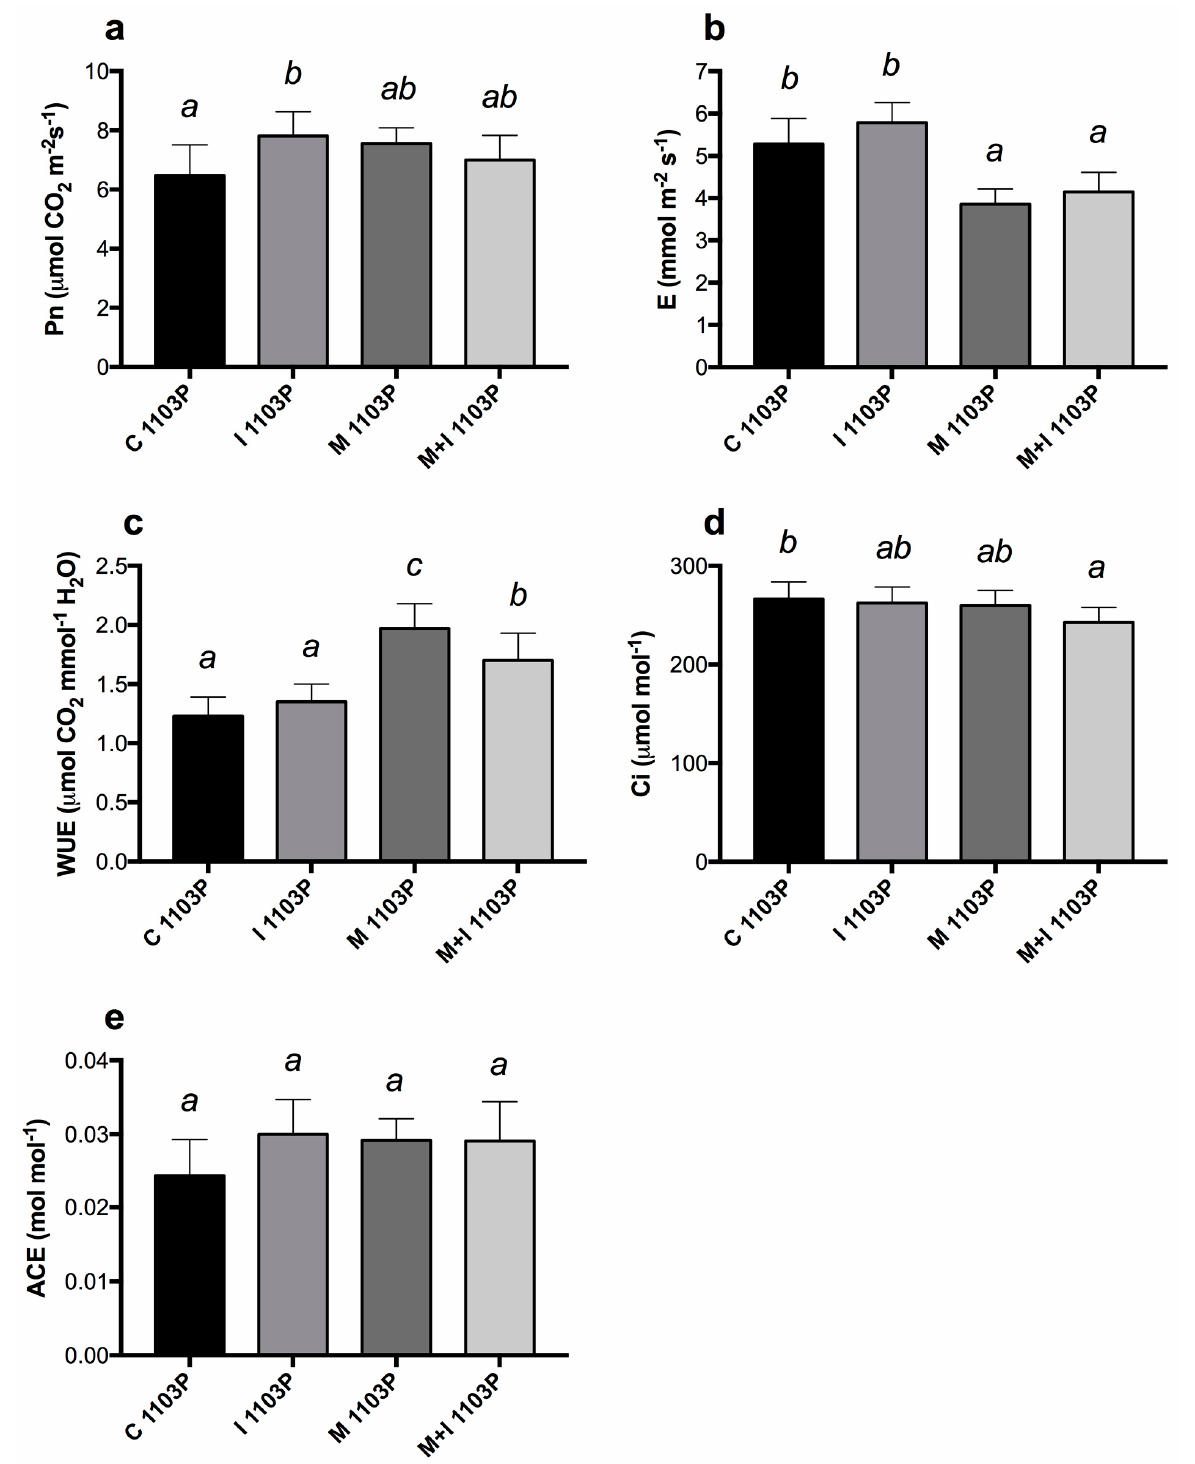
Figure 3. Leaf gas exchange in ‘Glera’ plants grafted onto 1103P rootstock at véraison. Performances of net photosynthesis (Pn) ( a ), transpirations ( b ), water use efficiency (WUE) ( c ), intercellular CO 2 concentration (Ci) ( d ), apparent carboxylation efficiency (ACE) ( e ). Data are expressed as mean ± SD ( n = 10) of randomly selected plants over 2020 and 2021 seasons. Different lowercase letters above the bars indicate significant differences according to’Tukey's HSD test ( p < 0.05). C, control plants; I, Inducer-treated plants; M, AMF mixed inoculum-treated plants; M+I AMF mixed inoculum + In- ducer-treated plants.